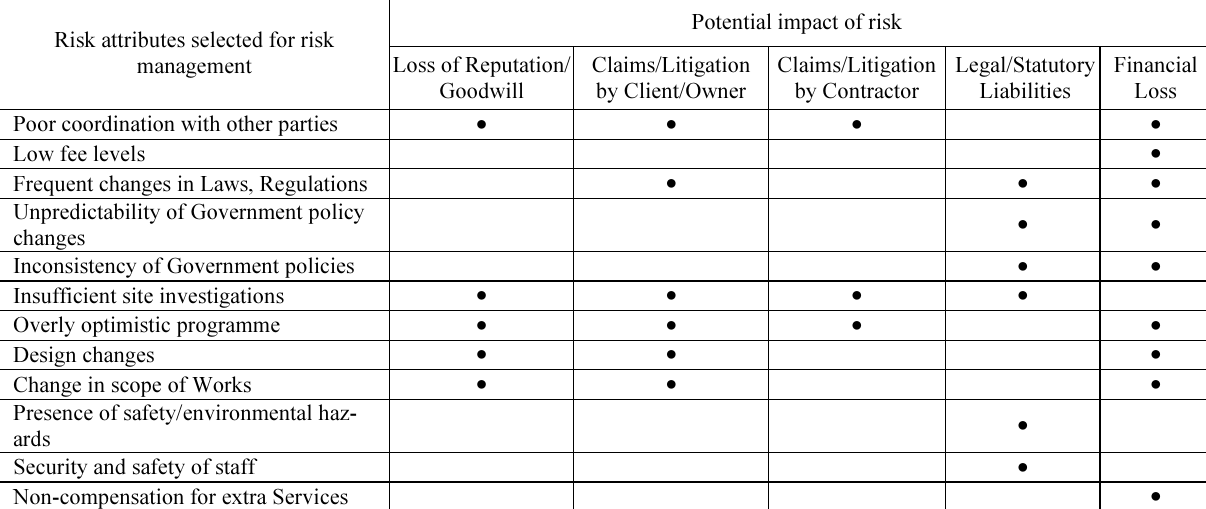
Table 6. Outcome of the application of Risk Assessment Framework to a test Case Risk attributes selected for